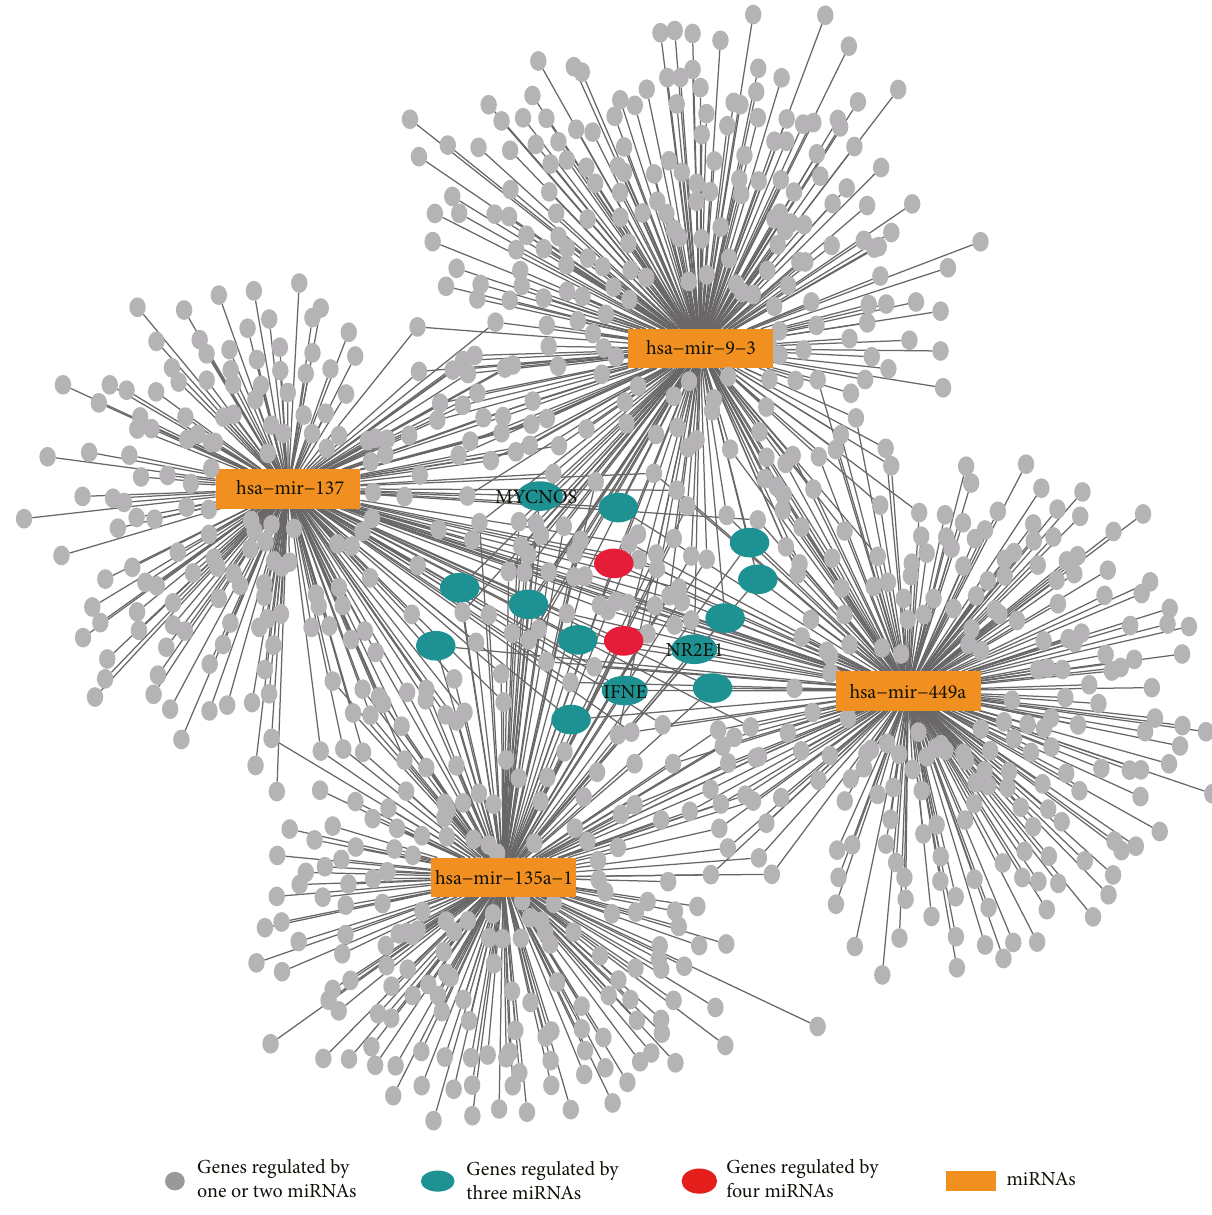
Figure 3: The miRNA-mRNA interaction subnetwork in BRCA. The four miRNAs in the network were reported to be associated with AML. In the fi gure, 13 mRNAs (cyan dots) and 2 mRNAs (red dots) were predicted to be connected with three and four miRNAs, respectively. The genes correlated with cancers were marked with their gene